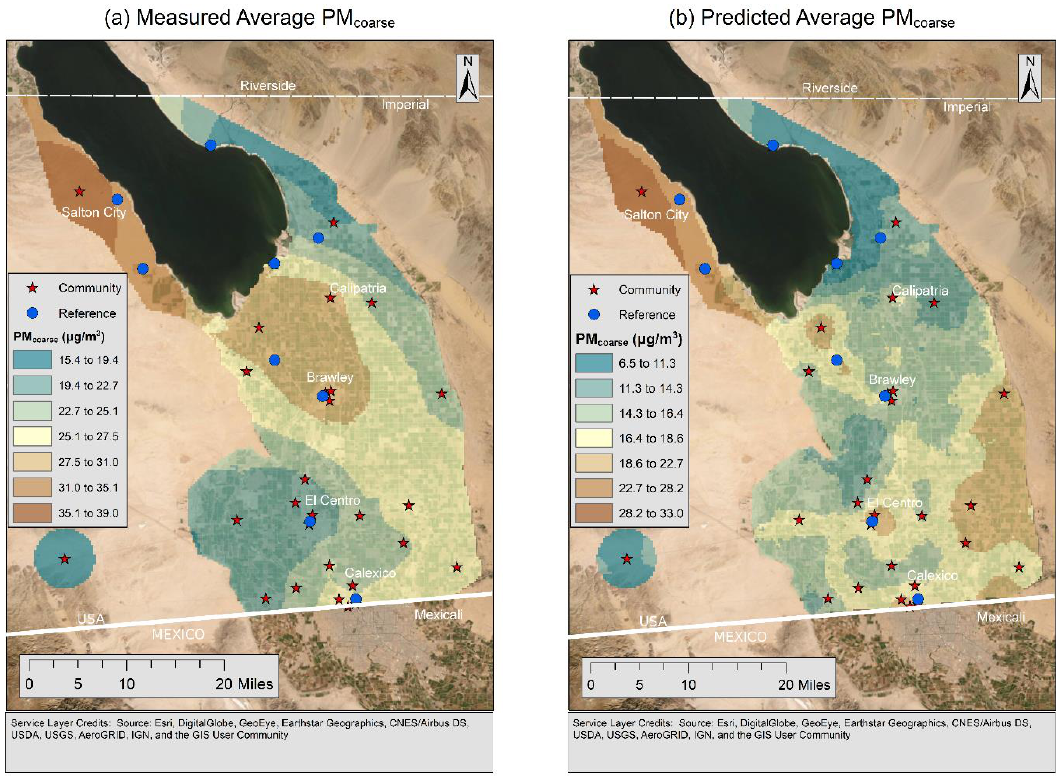
Figure 3. ( a ) Measured average PM coarse ; ( b ) predicted average PM coarse.